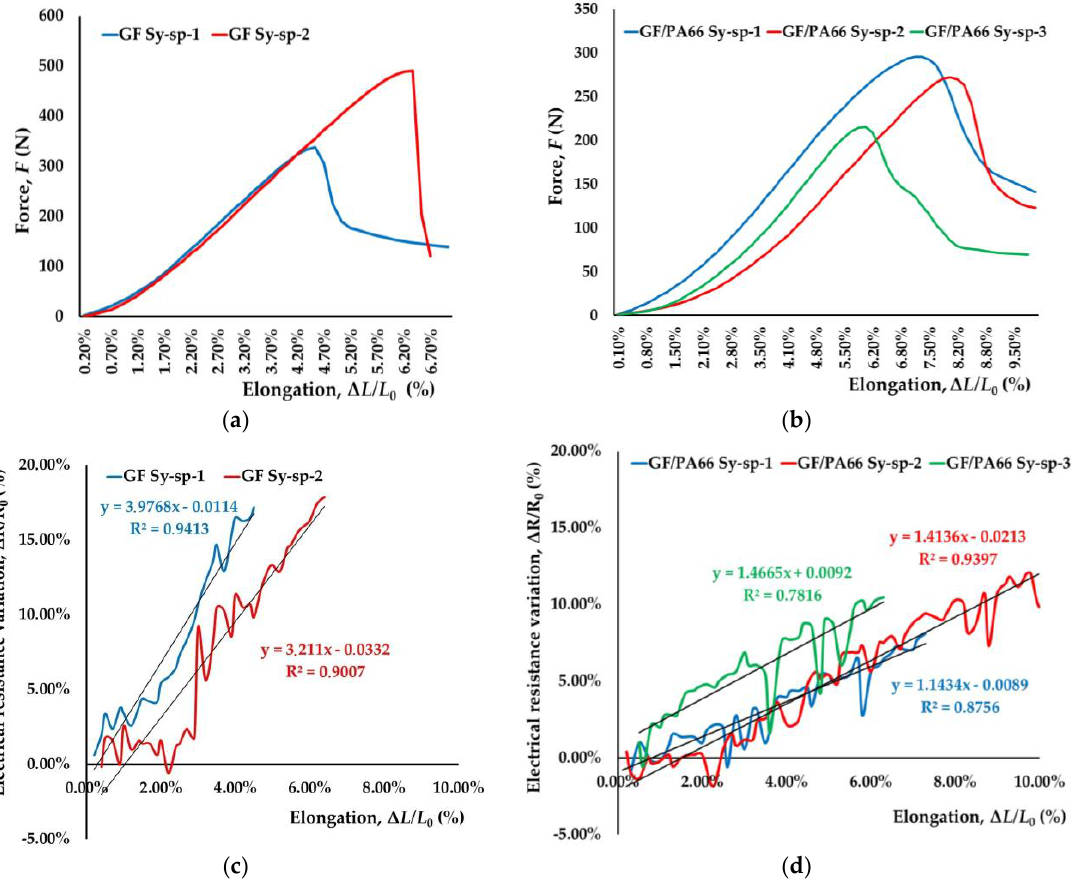
Figure 11. Electromechanical tests of textile sensors developed by silver drops added after copper wires insertion around conductive coated yarn: ( a , c ) GF Sy-sp sensors , ( b , d ) GF/PA66 Sy-sp sensors.